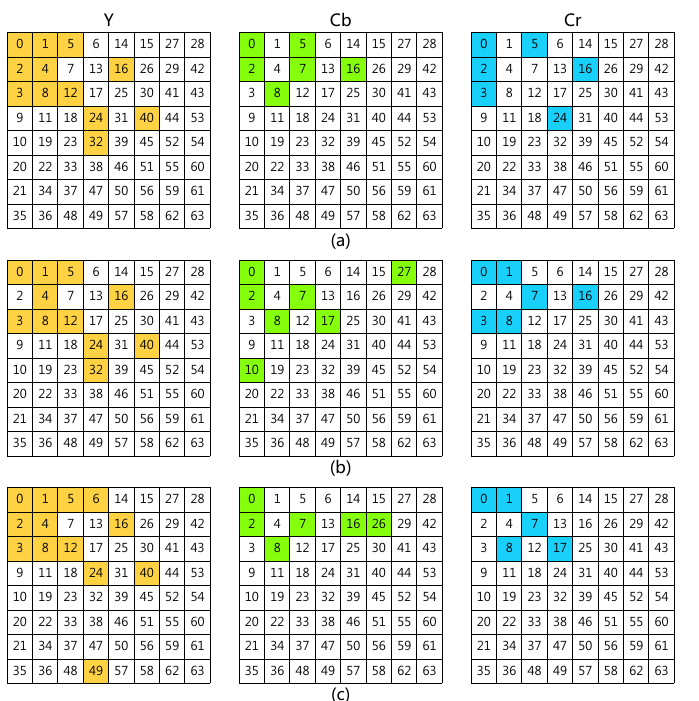
Figure 1. ( a ) The frequency selection of setting-1. ( b ) The frequency selection of setting-2; ( c ) The frequency selection of setting-3. The colored grids are the selected frequencies. Yellow grids are fre- quencies selected from Y , green grids are frequencies selected from Cb and blue grids are frequencies selected from Cr . The number of the selected grids was 24. e3 and e4 used the frequencies listed in ( a ). e7 and e8 used the frequencies listed in ( b ). e11 and e12 used the frequencies listed in ( c